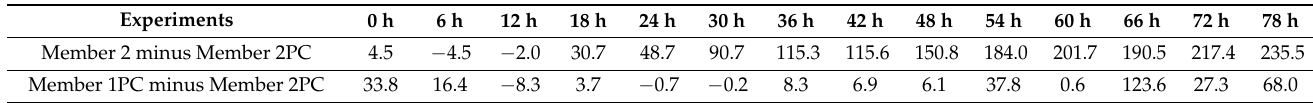
Table 1. The total track error differences (km) of Member 2 minus Member 2PC and Member 1PC minus Member 2PC, where positive values represent the superiority of Member